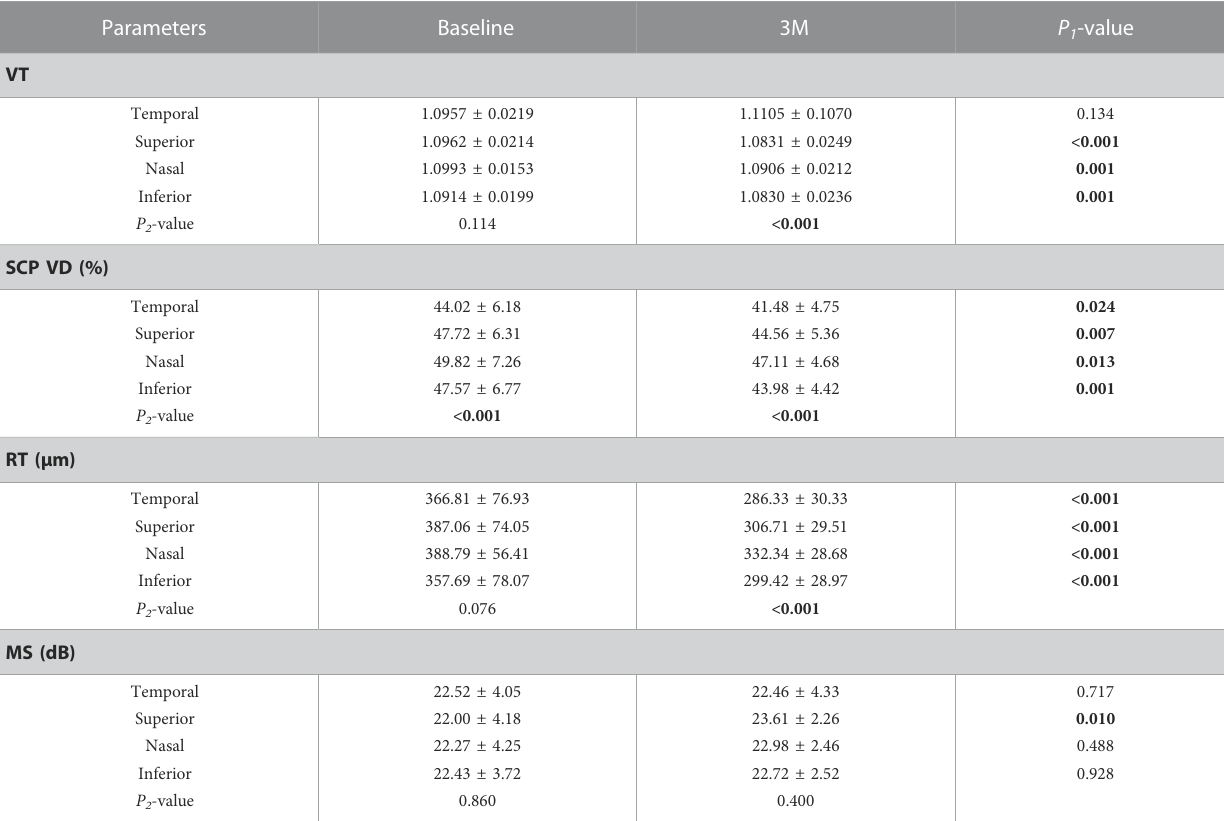
TABLE 3 Comparison of MS and anatomical parameters of different quadrants at baseline and 3 months (3M) after surgery in eyes with iERM.